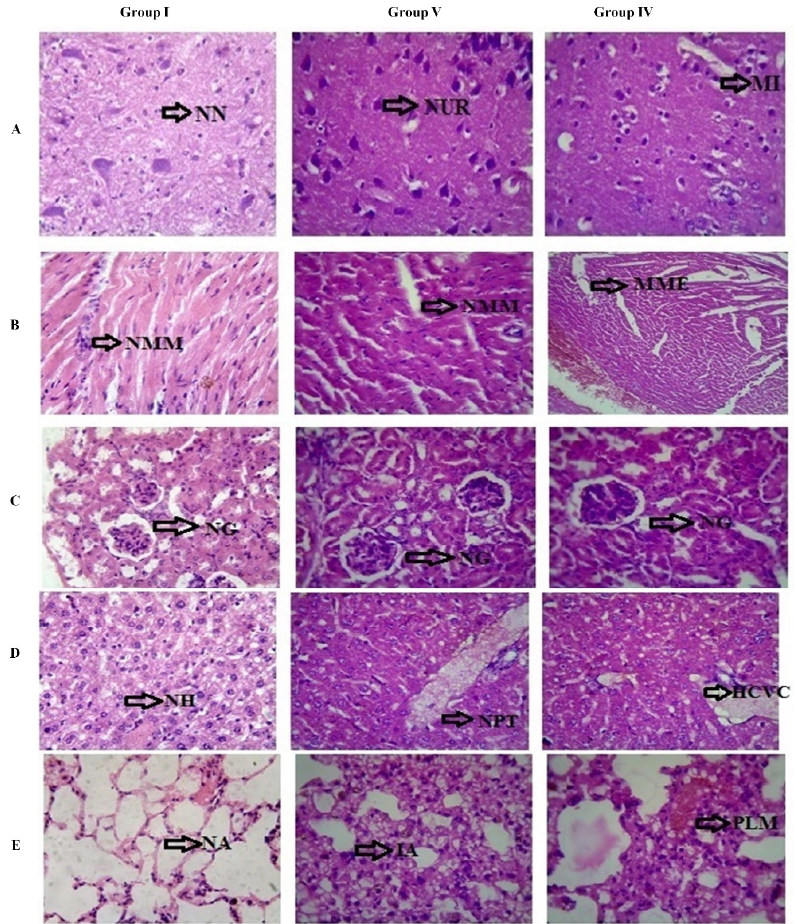
Figure 3. Histopathological analysis of acute toxicity studies. Group I: Control; Group V: survival (1250 mg/kg); Group IV: lethal (1500 mg/kg). ( A ) Brain section; ( B ) Heart section; ( C ) Kidney section; ( D ) Liver section; ( E ) Lung section; NN: Normal Neurons; NUR: Neurons Unremarkable; NMM: Normal Myocardium Myocytes; MME: Myocytes Mild Edema; NG: Normal Glomerulus; NH: Normal Hepatocytes; NPT: Normal Portal Tract; HCVC: Hepatocyte Central Vein Congestion; NA: Normal Alveoli; IA: Interconnected Alveoli; PLM: Pigment Laden Macrophages.